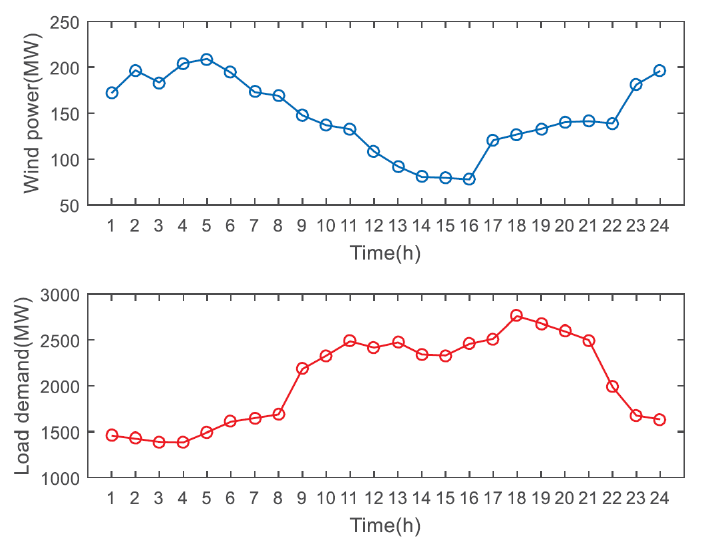
Figure 2. The hourly load demand and wind power prediction.